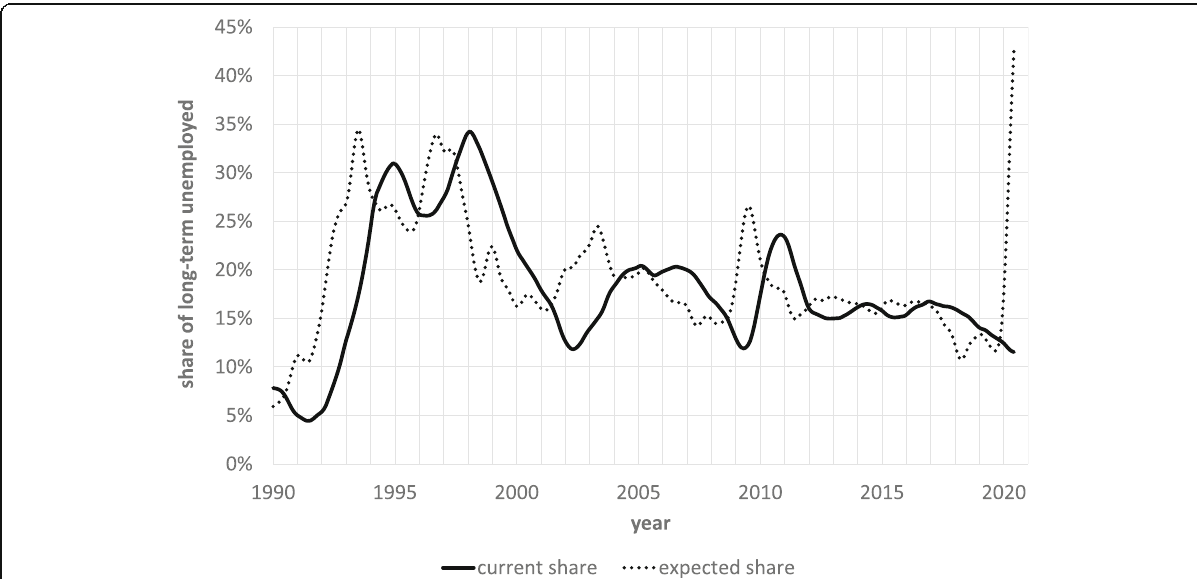
Fig. 4 Current and expected share of long-term unemployed, January 1990-June 2020, seasonally adjusted. Notes: The expected share of long- term unemployed in a given month equals the ratio of the area under the survivor curve of that month above the 11-month mark divided by the entire area underneath the same curve according to Eq